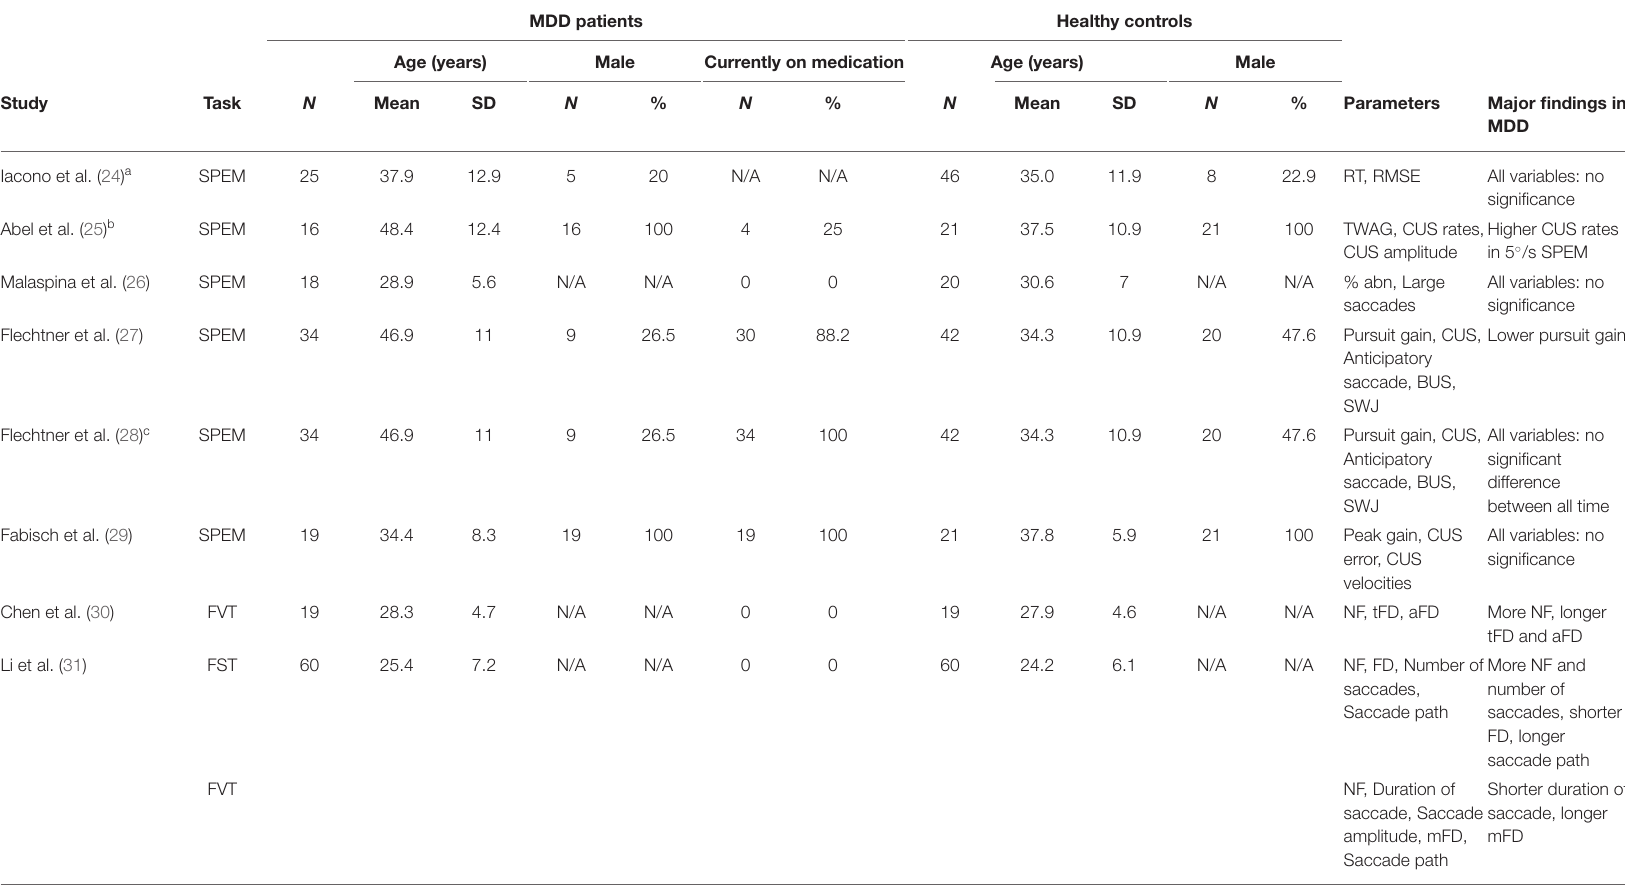
TABLE 1 | Demographic and clinical characteristics of the study subjects and major findings of patients with MDD in eight eye movement studies. MDD patients Healthy